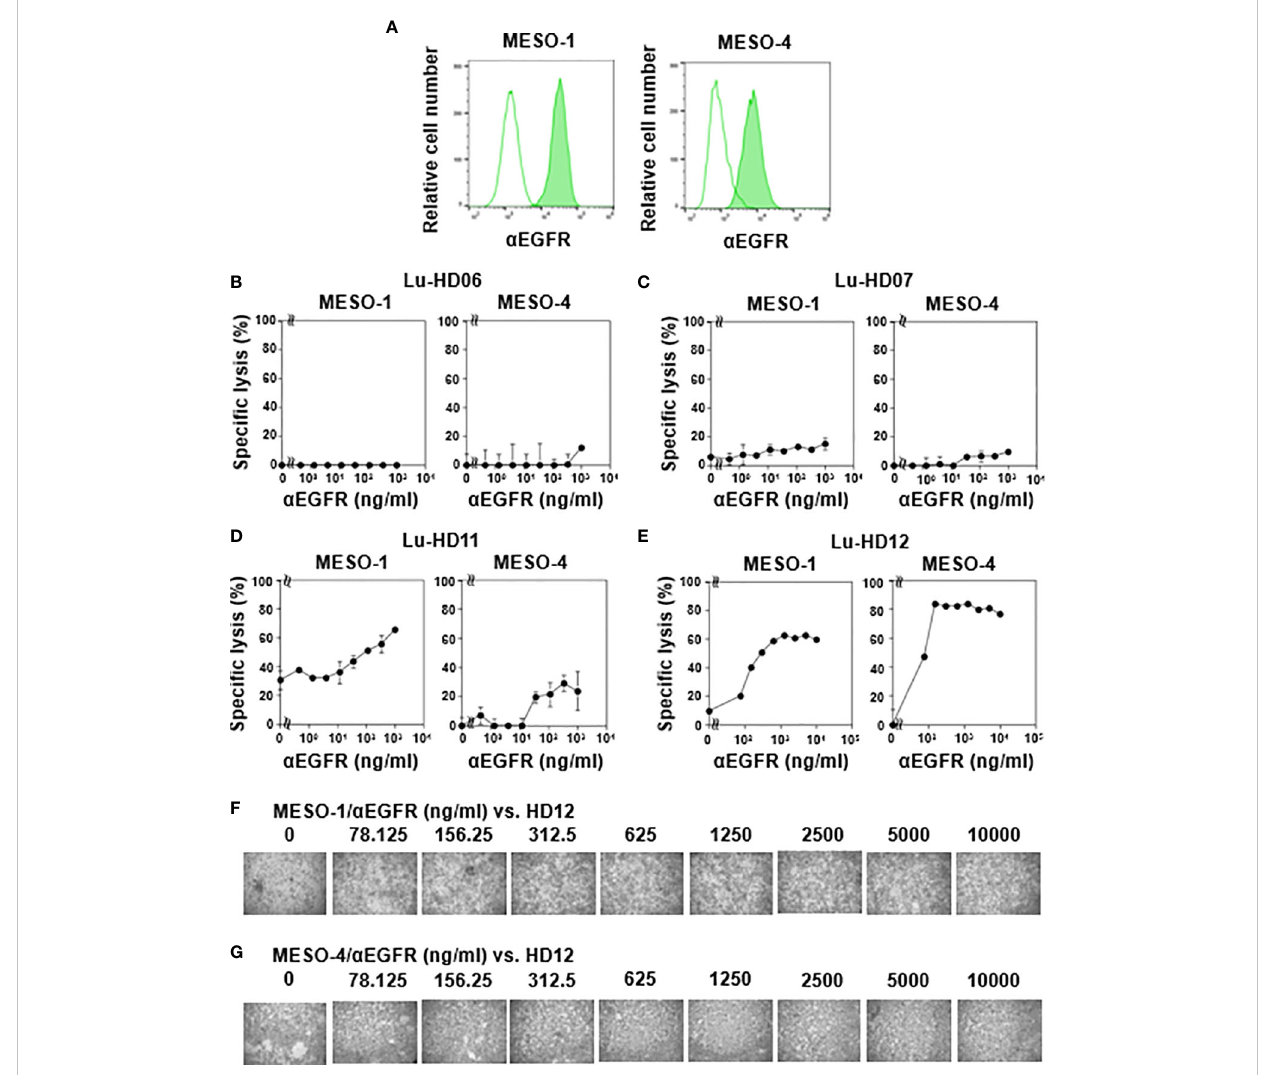
FIGURE 2 CD16-mediated cytotoxicity against MPM cells by gd T cells. (A) Expression of EGFR on MPM cells. Flow cytometric analysis of MESO-1 and MESO-4 for the expression of EGFR. Open areas represent control staining and closed areas cell staining with anti-EGFR mAb. (B – E) Effect of expression levels of CD16 on cytotoxicity against MPM cells. MPM cells were challenged by CD16-low gd T cells (HD06, B and HD07, C) or CD16-high gd T cells (HD11, D and HD12, E) at 37 °C for 48 h and speci fi c lysis (%) was determined based on luciferase assay. (F, G) Microscopic analysis of MPM cells challenged by gd T cells in the presence of anti-EGFR mAb. Cell mixtures in (E) were observed under a microscope for MESO-1 (F) and MESO-4 (G)